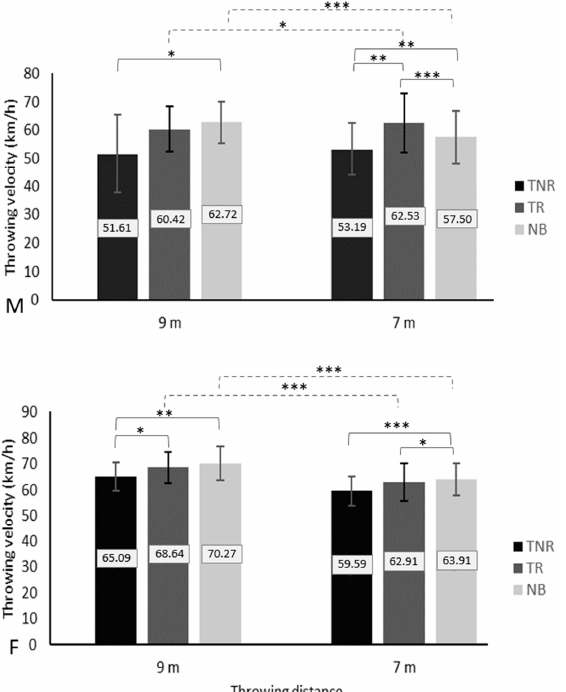
Figure 2. Male (M) and female (F) players’ throwing velocity (radar) for velocity target according to throwing distance (7 and 9 m) and ball type (traditional ball with no resin—TBNR; traditional ball with resin—TBR; and new ball—NB). Note: continuous lines indicate significant differences between the three balls at a specific distance. Discontinuous lines indicate significant differences between the two throwing distances in a specific ball. * p < 0.05; ** p < 0.01, *** p < 0.001.